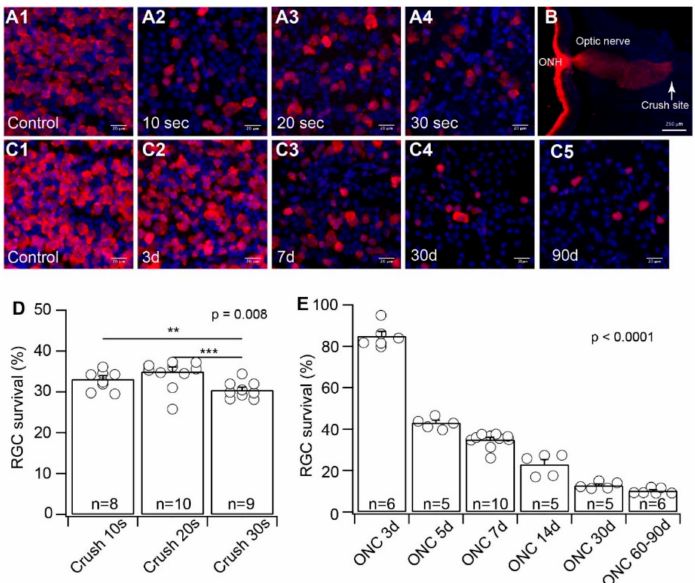
Figure 1. Evaluation of crush time and time after optic nerve crush (ONC) on the death of retinal ganglion cell (RGCs). We first validated whether crushing the optic nerve for di ff erent lengths of time causes RGC death to a di ff erent extent, and the time course of RGC death after ONC. ( A ) Representative images of flat-mount retinas without injury ( A1 ) or seven days after optic nerve clamp for 10 s ( A2 ), 20 s ( A3 ), and 30 s ( A4 ), respectively. RGCs are labeled by anti-RNA-binding protein with multiple splicing (RBPMS) antibody (red), and all nuclei in the ganglion cell layer (GCL) are labeled by DAPI (4 (cid:48) ,6-diamidino-2-phenylindole) (blue). ( B ) A representative image of the longitudinal cross-section of the proximal portion of the optic nerve and the posterior portion of the eye seven days after ONC. The posterior retina and proximal optic nerve before the crush site are labeled by Cholera Toxin Subunit B (CTB) (red). The tissue surrounding the optic nerve is labeled by DAPI (blue). The crush site is marked by the CTB labeling. ( C ) Representative images of flat-mount retinas in control ( C1 ), three days ( C2 ), seven days ( C3 ), 30 days ( C4 ), and 90 days ( C5 ) after 20 s of optic nerve clamp. RGCs are labeled by anti-RBPMS antibody (red), and all nuclei in the GCL are labeled by DAPI (blue). ( D ) Survival rates of RGCs labeled by anti-RBPMS antibody as a function of time of optic nerve clamp (ANOVA test). ( E ) Survival rates of RGCs labeled by anti-RBPMS antibody as a function of time after ONC (ANOVA test). ** 0.001 < p < 0.01, *** p < 0.001. Each circle indicates an individual eye. The number of n in each column of panels D and E indicates the number of eyes for each